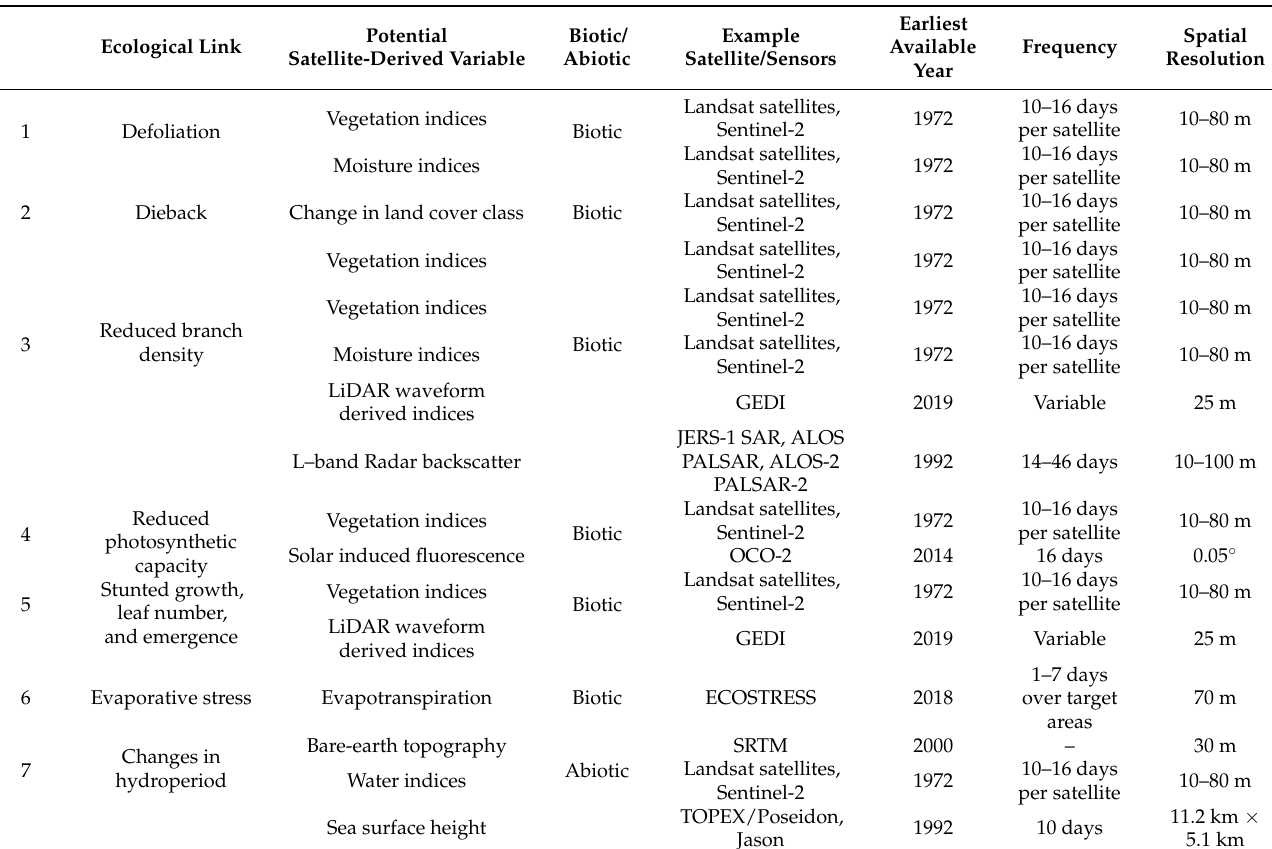
Table 1. Satellite-derived variables and their ecological link to mangrove degradation. Variables were identified with a conceptual model of mangrove ecosystems (Figure 2).